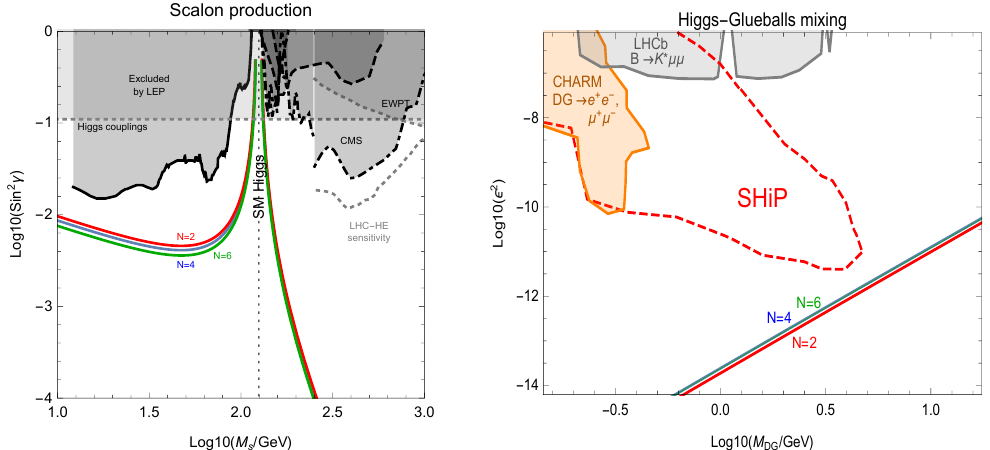
Figure 2 . On the left: predicted production cross section for the scalon, under the assumption that W reproduce the full DM abundance of the Universe and some extra new physics gives fast glueball decays. Signals are very supressed if glueballs decay slowly. On the right: predicted Higgs-glueball mixing angle as a function of the glueball mass M DG with the same